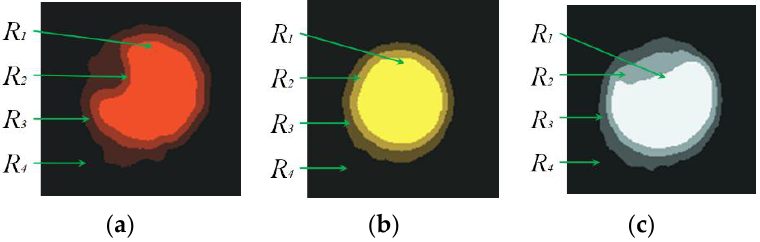
Table 1. The brightness of four regions after the marking point is segmented.